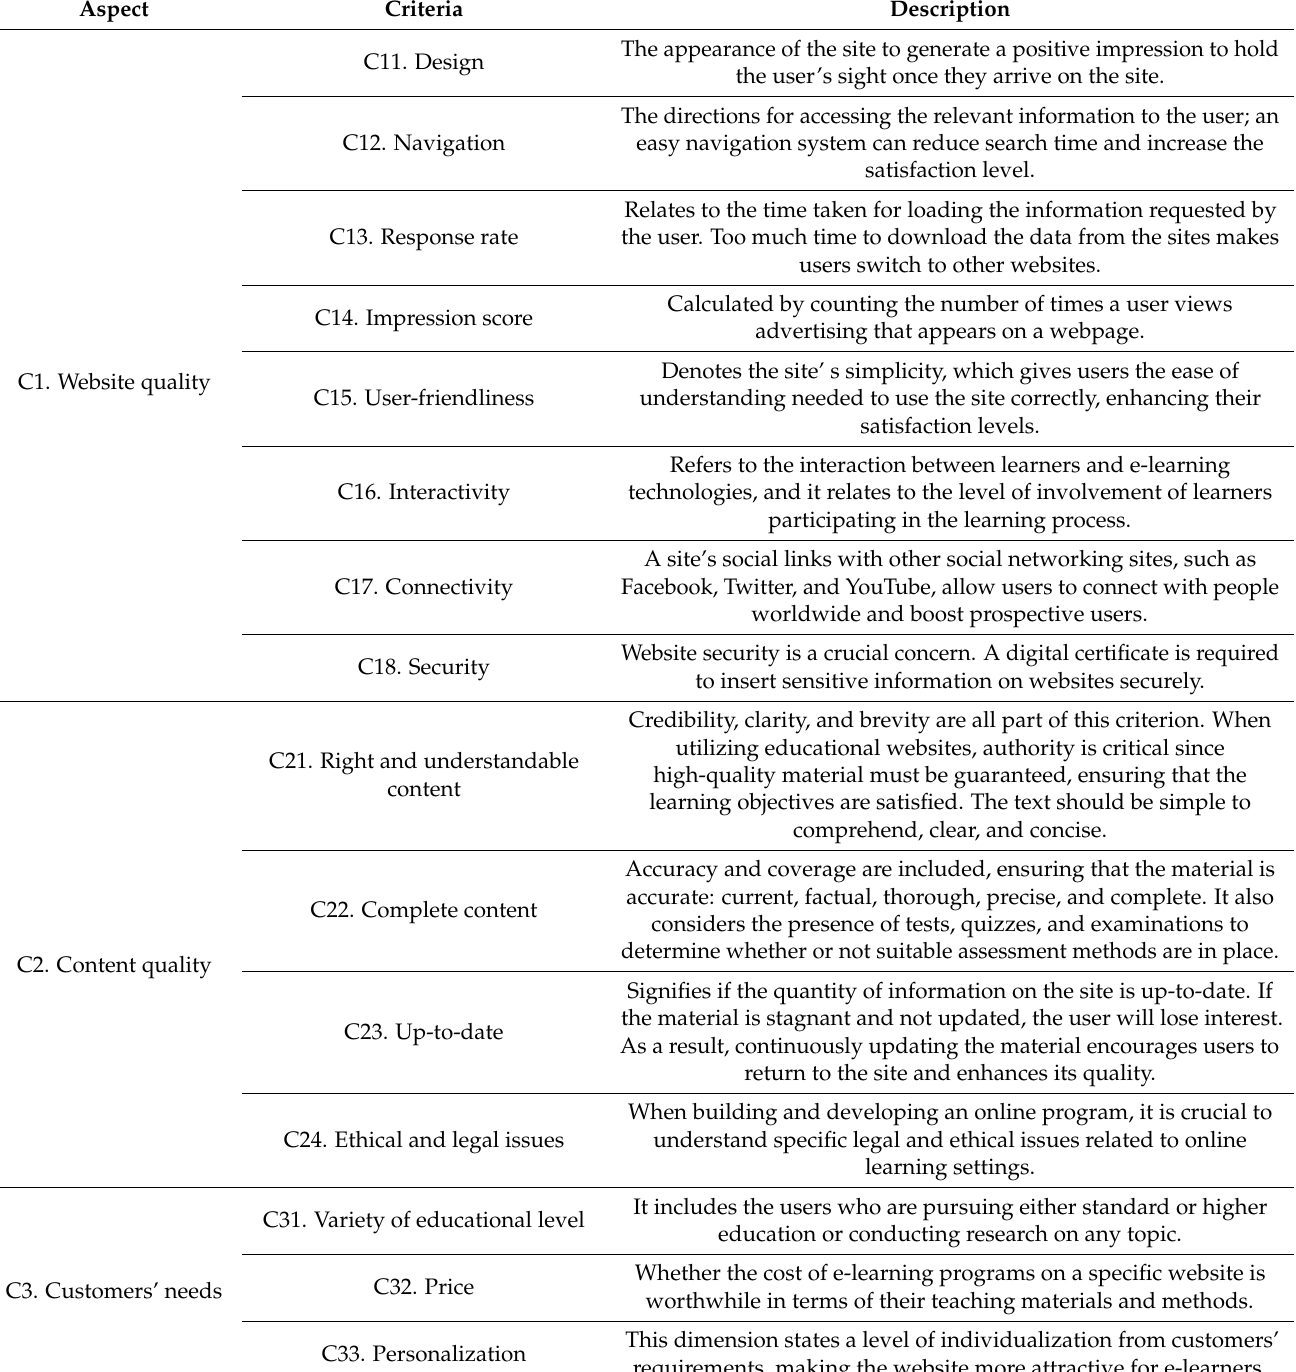
Table 5. The criteria and their definition as used in the